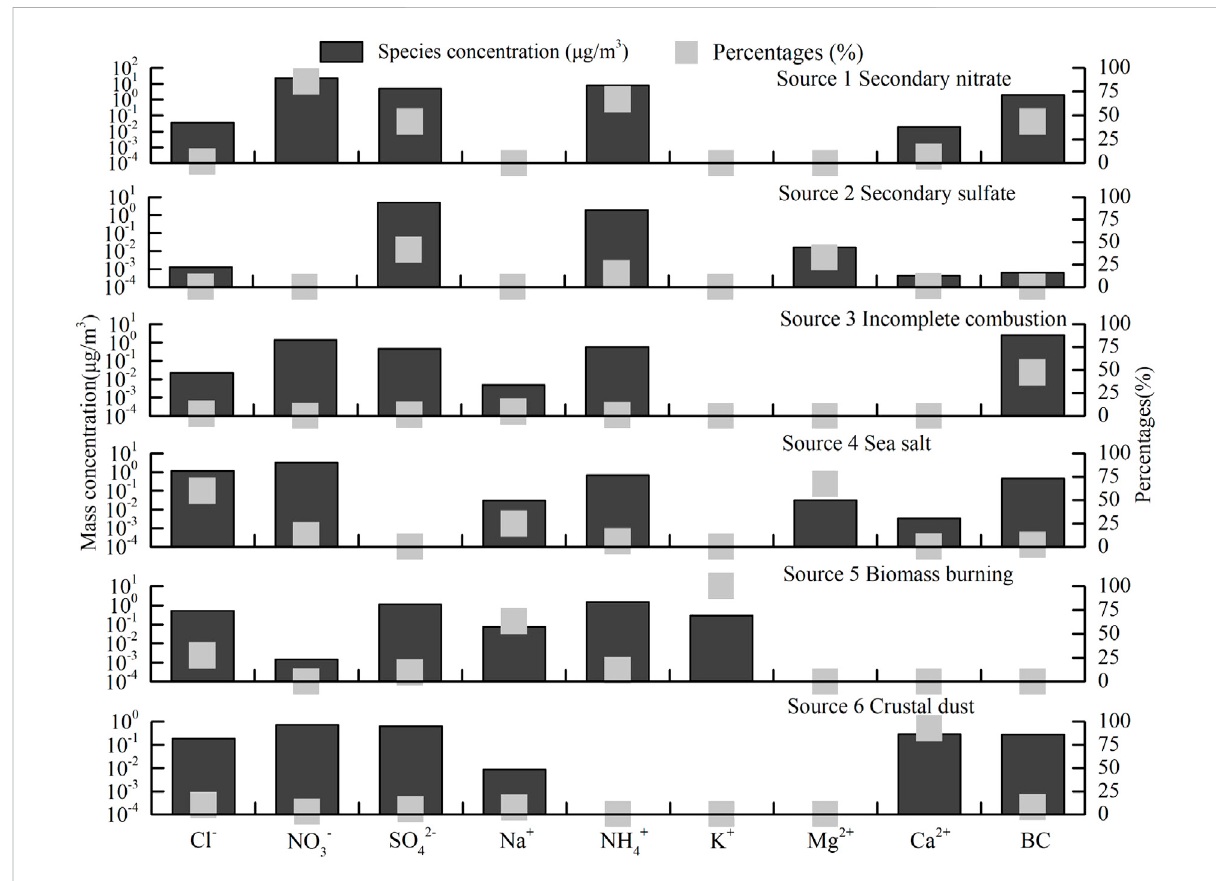
FIGURE 3 The resolved percentage for the source pro fi les derived by